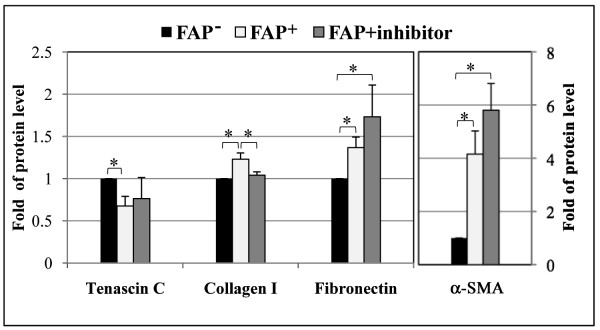
FAP modulates the expression levels of stromal α-SMA and assorted ECM molecules. Western analyses were used to determine the levels of desmoplastic marker α-SMA and assorted ECM proteins underlying the matrix differences mediated by FAP expression. The normalized fold ratios of the selected proteins by loading controls (β-actin or GAPDH) were assigned as one arbitrary unit. Compared to FAP- matrix proteins, α-SMA, fibronectin, and collagen I were significantly up-regulated in FAP+ 3D matrices (p = 0.009, p = 0.002, p = 0.001, respectively), while tenascin C was significantly down-regulated (p = 0.001). Note that although collagen I levels were rescued (p = 0.007) by inhibition of FAP activity during matrix production (FAP+inhibitor), levels of expression of fibronectin and α-SMA were only significantly increased when compared to FAP- (p = 0.04 in both cases) but not to FAP+ (p = 0.32 and p = 0.61, respectively). *denotes statistical significance.